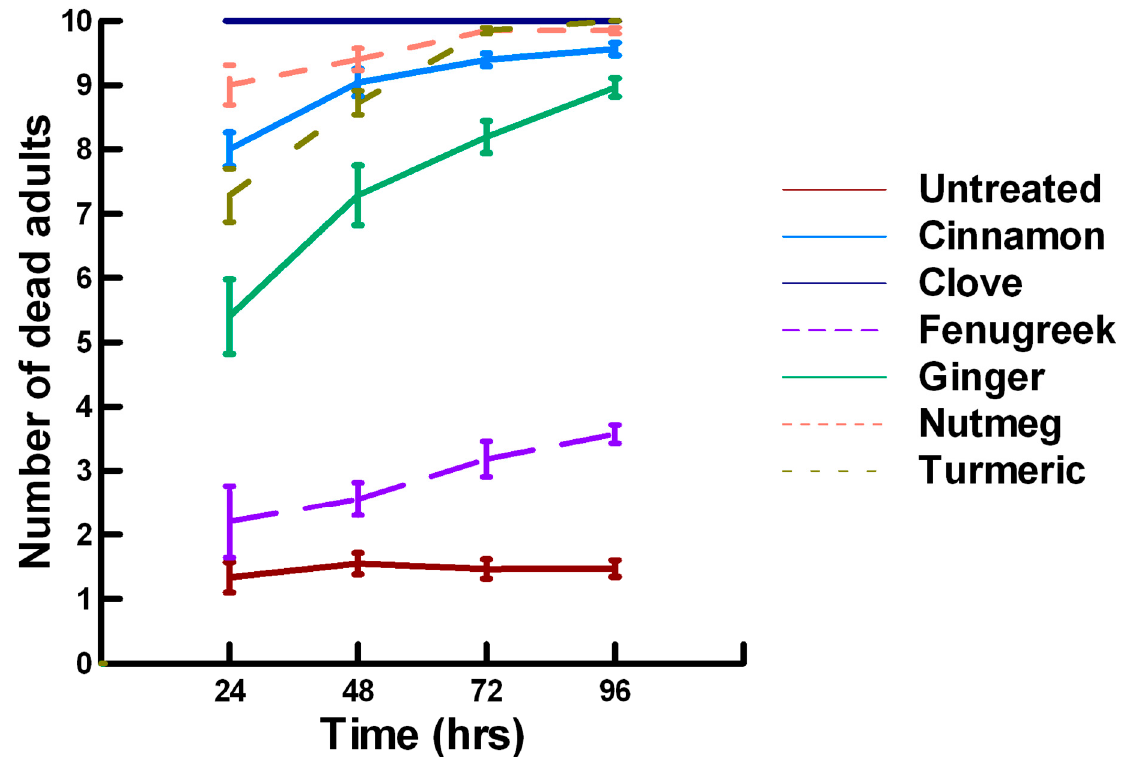
Figure 3. Acute contact toxicity with a low concentration of plant powders from the families Lauraceae (cinnamon), Myrtaceae (clove), Fabaceae (Fenugreek), Myristicaceae (nutmeg) and Zingiberaceae (ginger, turmeric) adherent to adult Pteromalus venustus . Means and standard error shown.